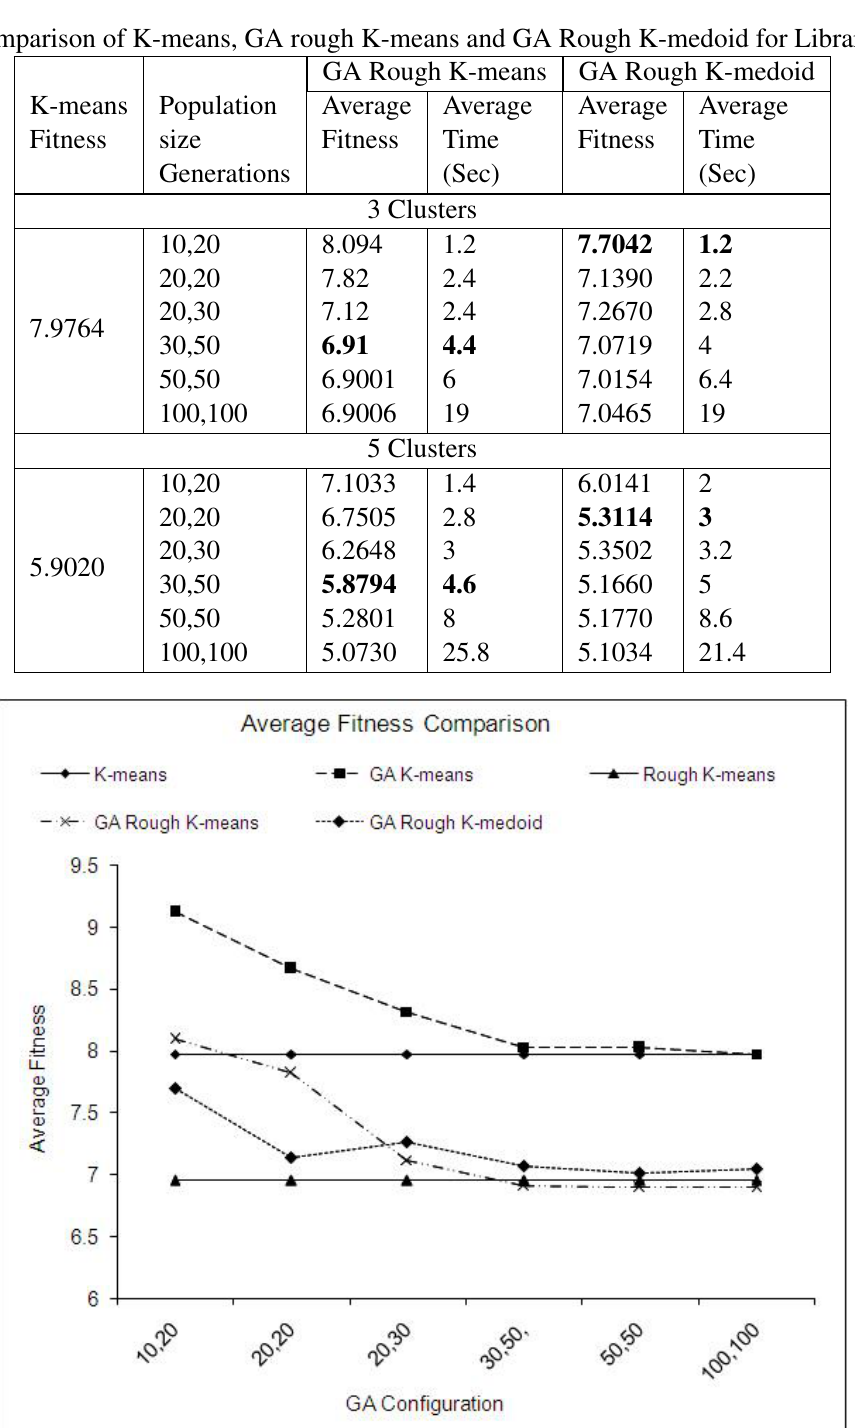
Figure 7: Comparison chart of different